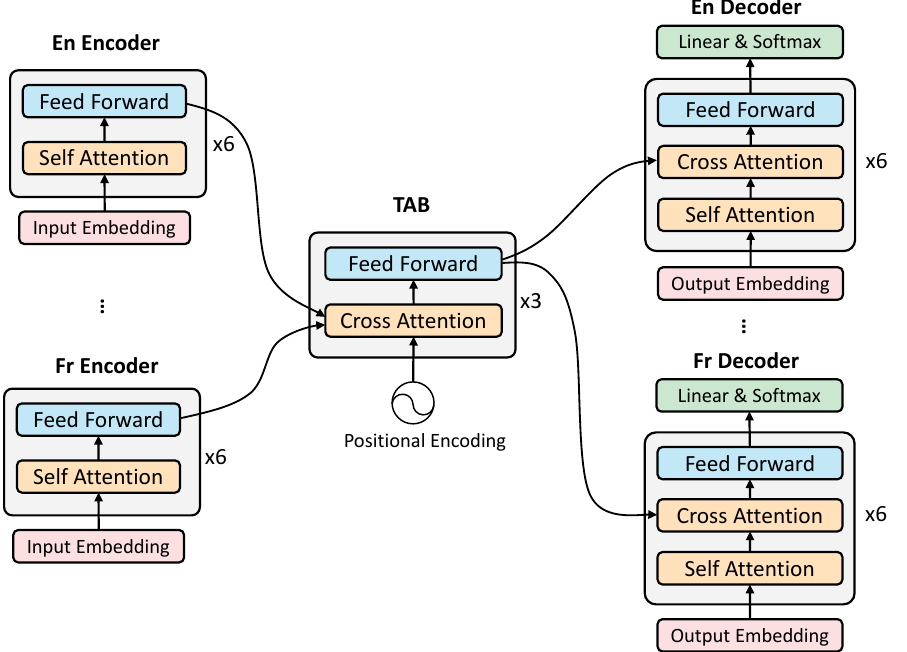
Figure 7. The architecture of the M2 model incorporated with the proposed Transformer attention bridge (TAB)